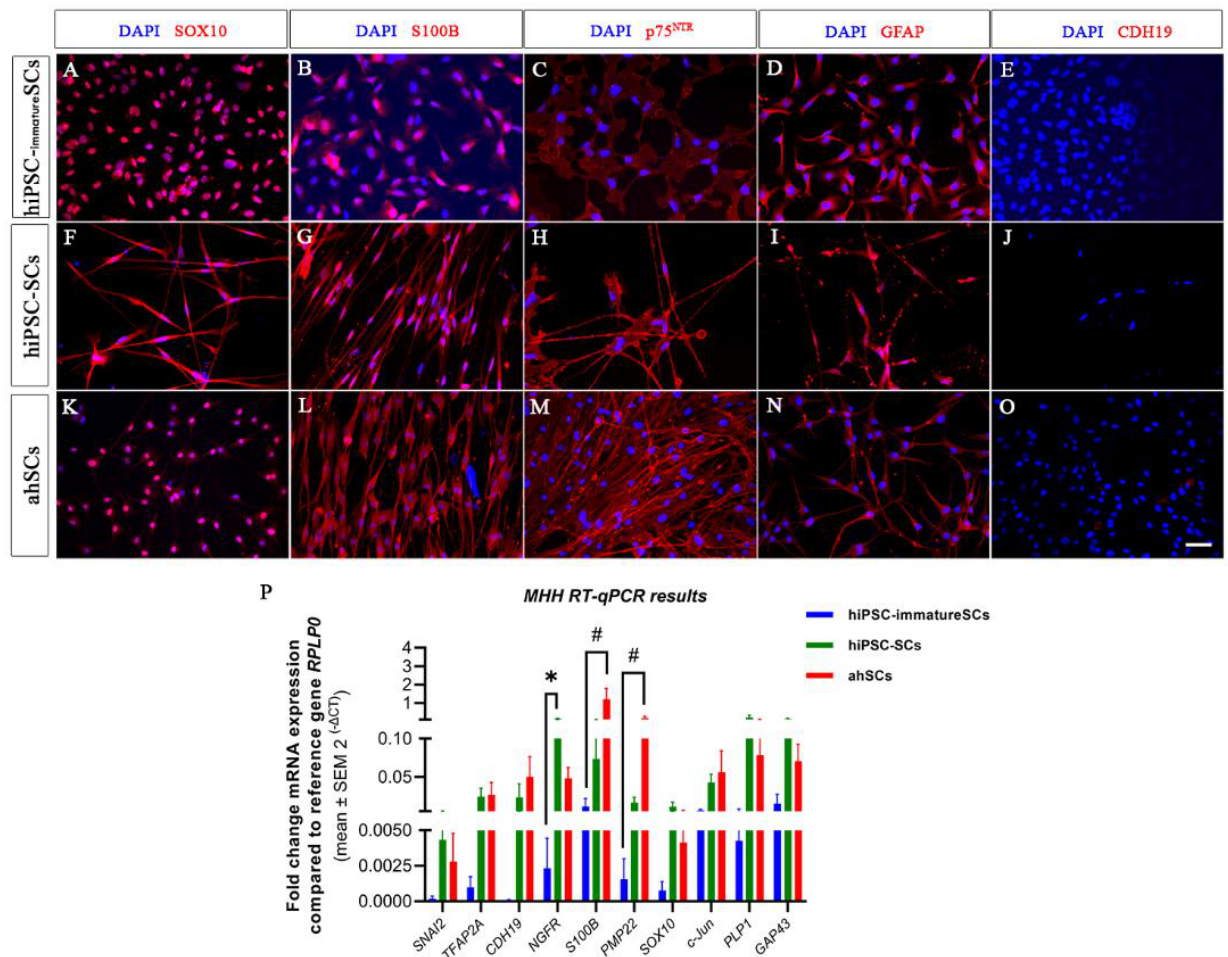
Figure 4. Comparative immunocytochemistry on hiPSC-immatureSCs, hiPSC-SCs and adult human Schwann cells (ahSCs). Schwann cell markers SOX10, S100B, p75 NTR , and GFAP were detected in hiPSC-immatureSCs ( A – E ), hiPSC-SCs ( F – H , I , J ) and ahSCs ( K – O ). All cells were negative for CDH19 ( E , J , O ). Cell nuclei were stained with DAPI (Blue). Scale bar: 50 µm. ( P ) MHH results of quantitative RT-qPCR for SNAI2, TFAP2A, CDH19, NGFR, S100B, PMP22, SOX10, c-Jun , PLP1 , and GAP43 in hiPSC-immatureSCs, hiPSC-SCs and ahSCs. Values were normalised to the reference gene RPLP0 . Statistical analysis with non-parametric Kruskal–Wallis test followed by Dunn’s multiple compansons test, * p < 0.05 hiPSC-immatureSCs vs. hiPSC-SCs; # p < 0.05 hiPS-immatureSCs vs. ahSCs. n = 3 cell cultures.